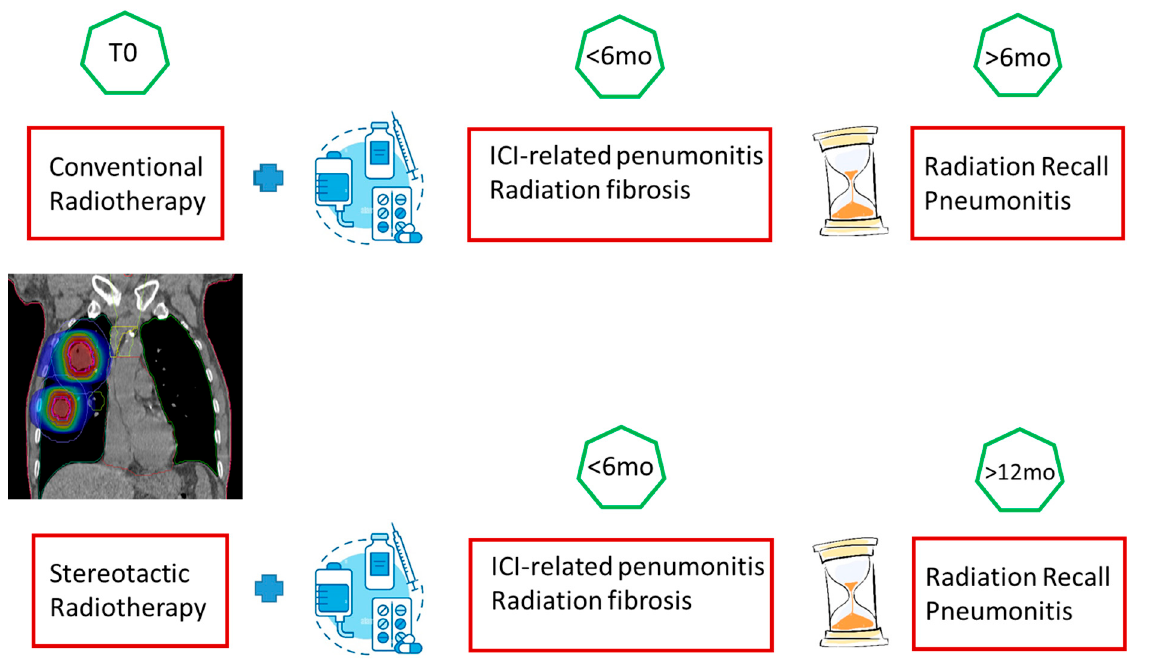
(Figure 3) given the similar radiological features between RP and RRP (homogeneous or patchy areas of ground-glass opacity or consolidation, progressing towards fibrosis) [111].